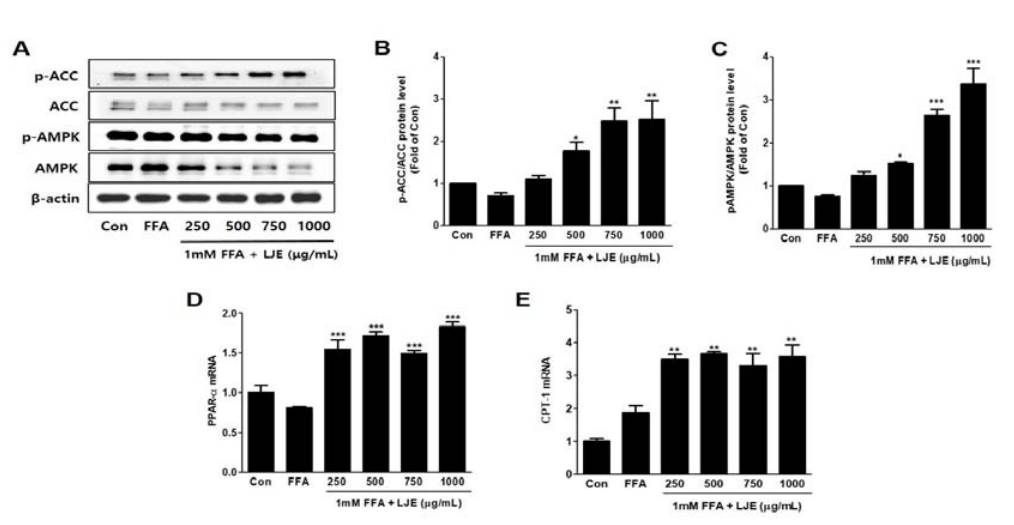
Figure 4. Effects of LJE on the phosphorylation of AMP-activated protein kinase (AMPK) and acetyl-CoA carboxylase (ACC) and the mRNA expression of fatty acid oxidation factors in HepG2 cells. ( A – C ) AMPK and ACC phosphorylation levels; ( D , E ) PPAR- α and CPT-1 mRNA levels. Data represent means ± SEM. * p < 0.05, ** p < 0.01, *** p < 0.001 vs. FFA.